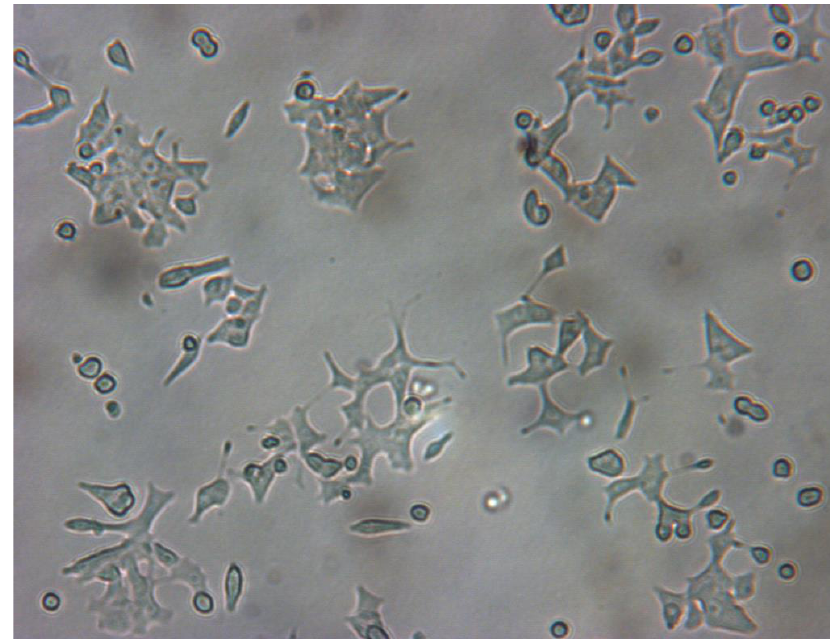
Figure 6. Cellular morphology of RINm5F cell grown in 96-well flat-bottomed plates.